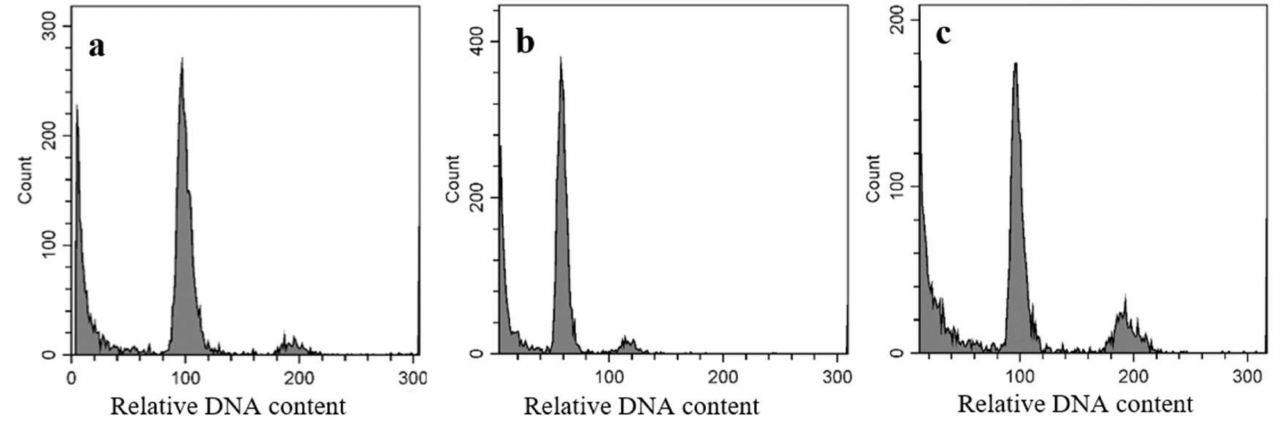
Figure 2. Flow cytometric analyses of rice calli: histograms demonstrate the relative DNA content of ( a ) somatic tissue culture-derived callus, diploid control; ( b ) AC-derived haploid callus; ( c ) AC- derived diploid